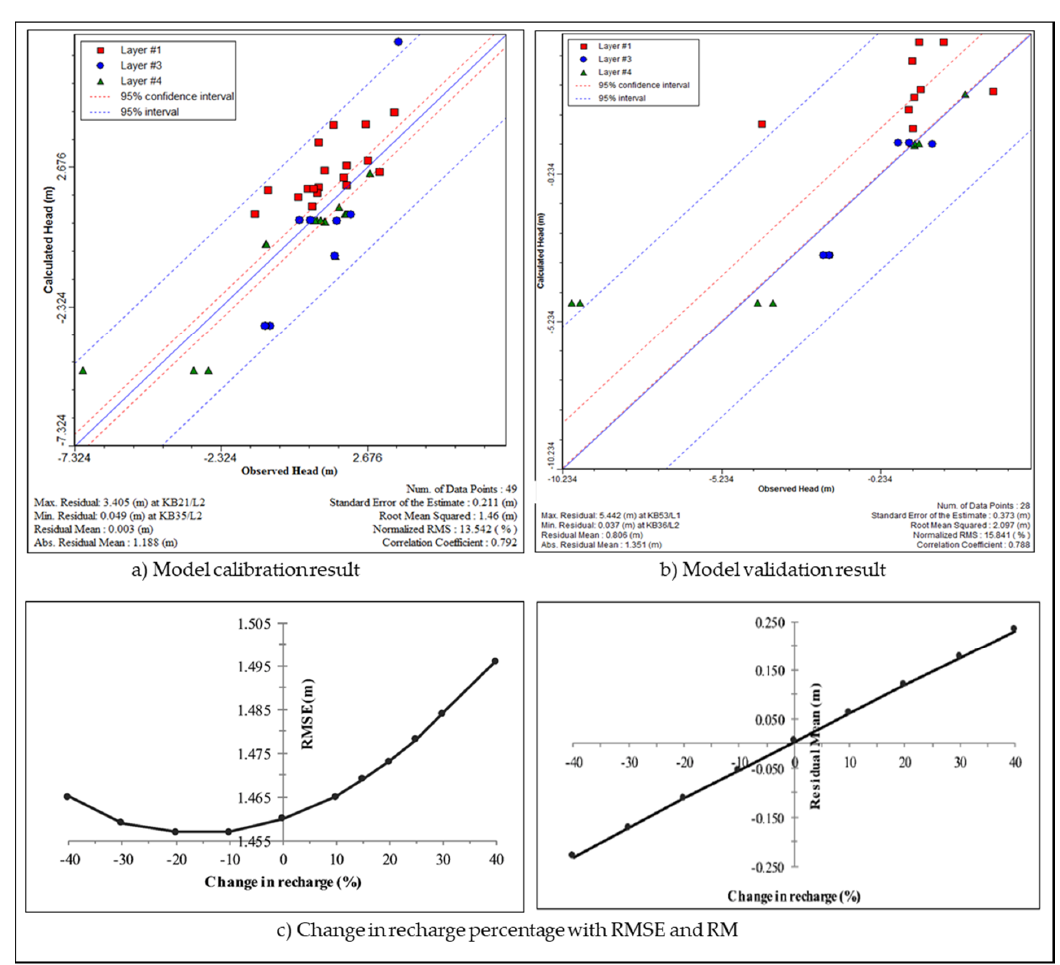
Figure 5. ( a ) Model calibration result; ( b ) model validation result; and ( c ) change in recharge percentage with RMSE and RM.